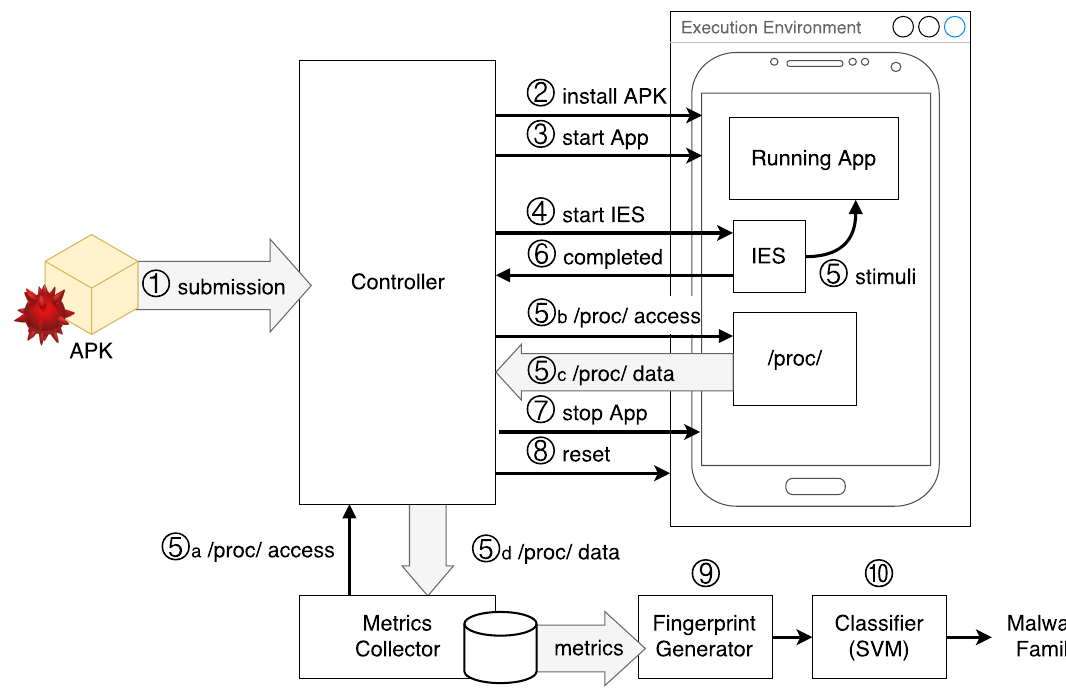
Figure 1. Proposed architecture and workflow for AndroDFA. IES, Input Events